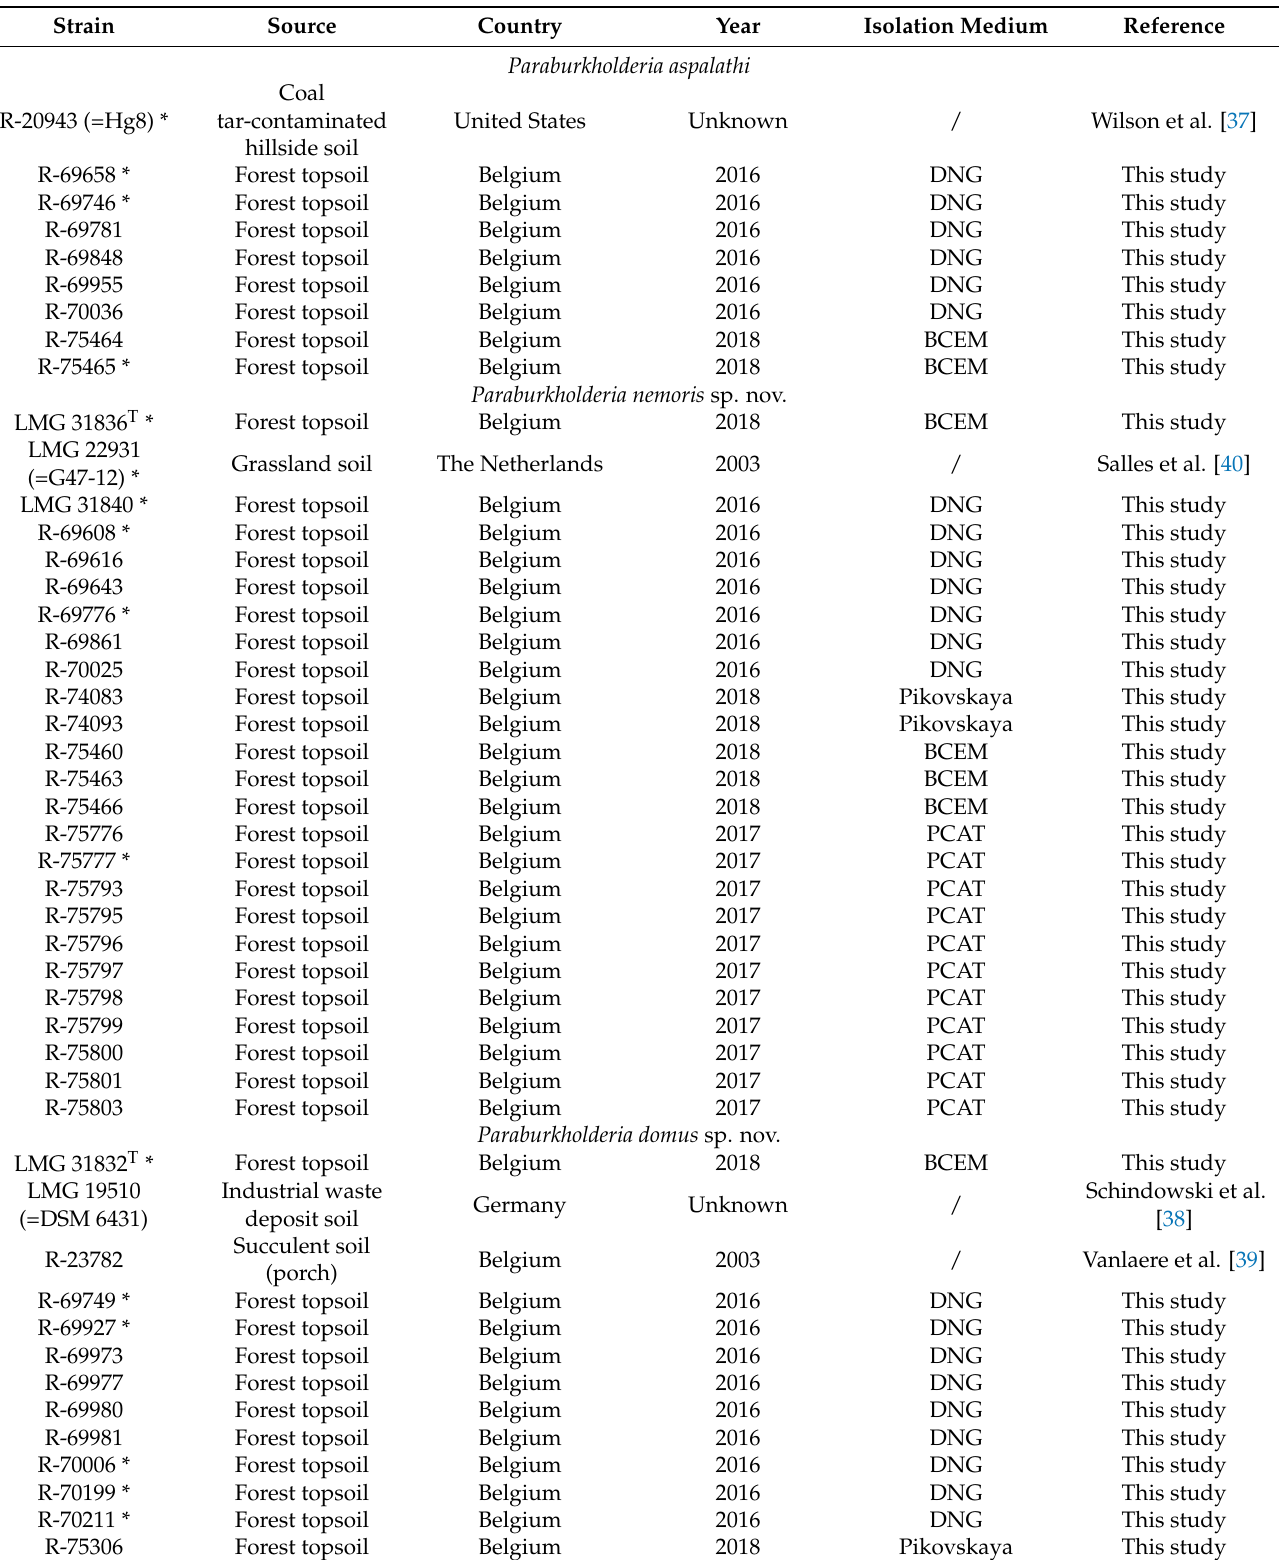
Table 1. Overview of the isolates studied. Isolates marked with an asterisk were selected for whole genome sequence analysis.